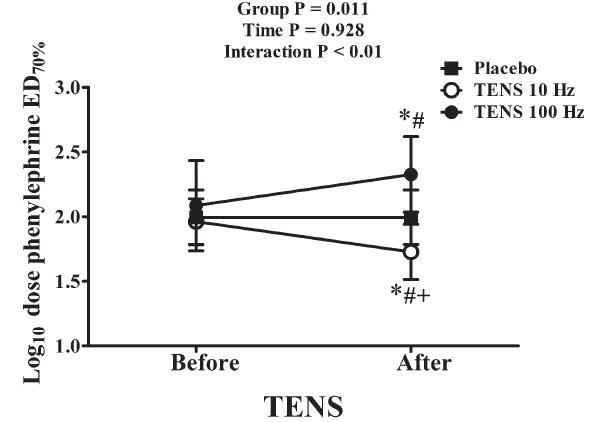
Figure 3. Phenylephrine dose required to reach ED 70% of venoconstriction. Data are reported as means±SD. *P , 0.05, before vs after; # P , 0.05, TENS vs placebo; + P , 0.05, TENS 10 Hz vs TENS 100 Hz (two-way ANOVA with repeated measures followed by the Bonferroni